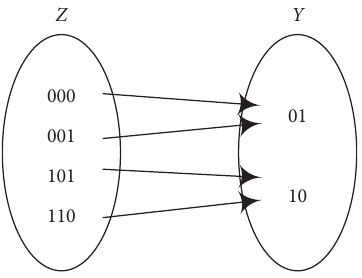
Figure 1: Diagram represents a function with domain